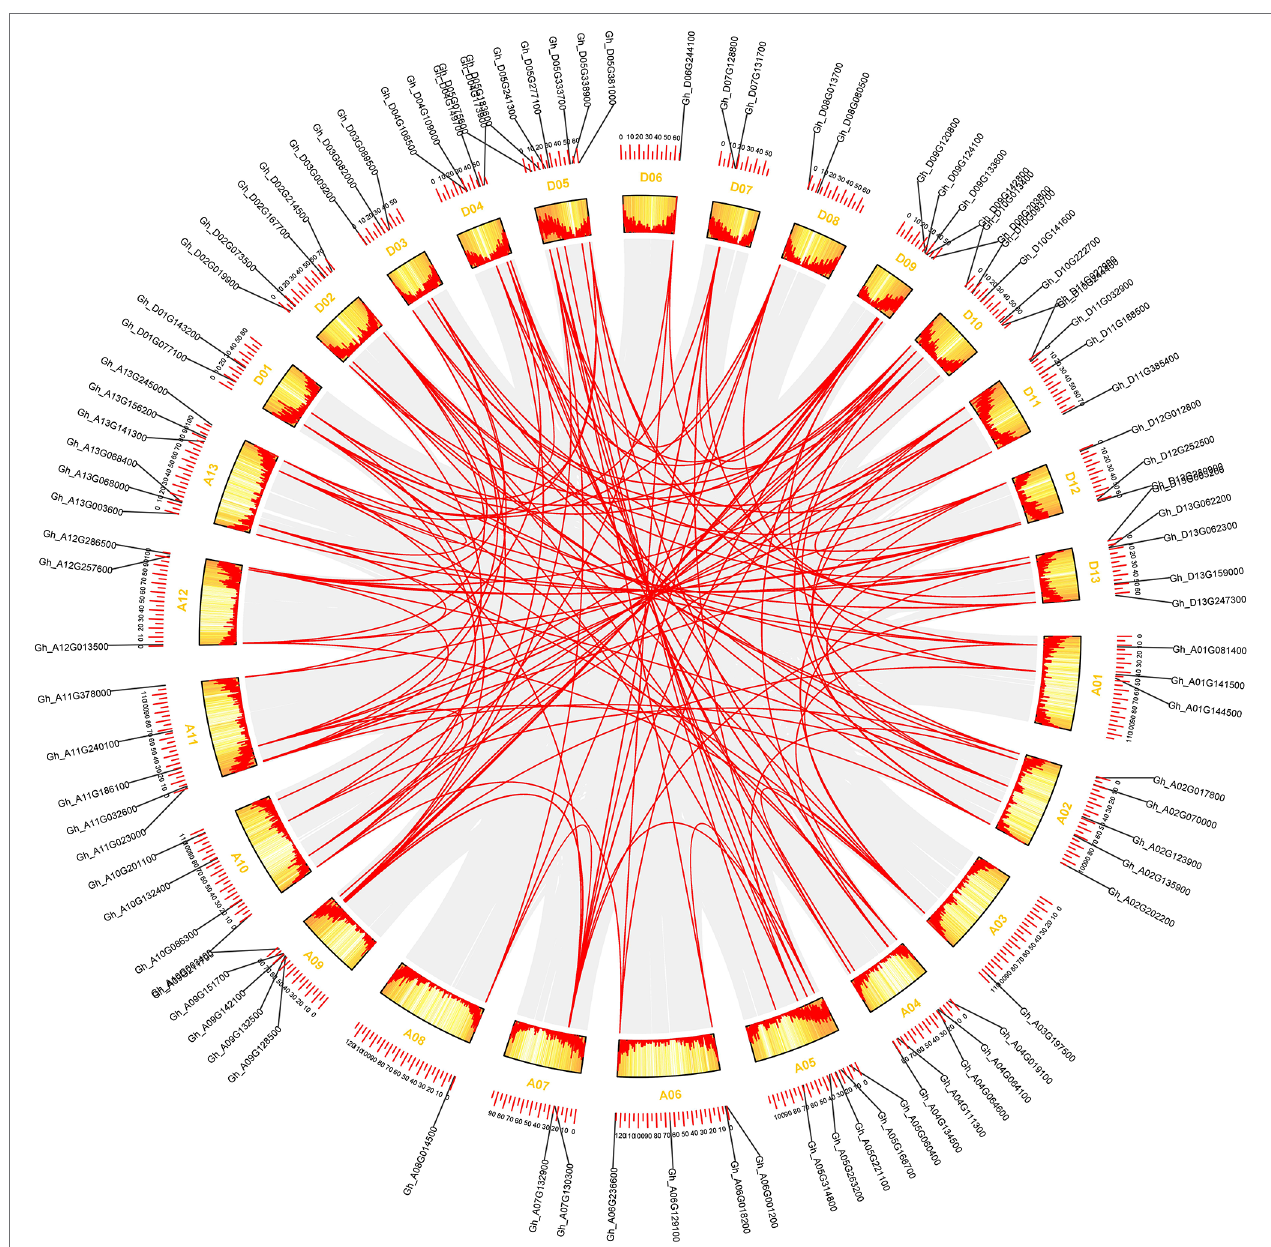
FIGURE 3 | The synteny relationship of GhCDPK genes. MCScanX was used to detect genome collinearity and tandem repeats under default parameters, and CIRCOS was used to display collinearity. The red line represents paralogous gene